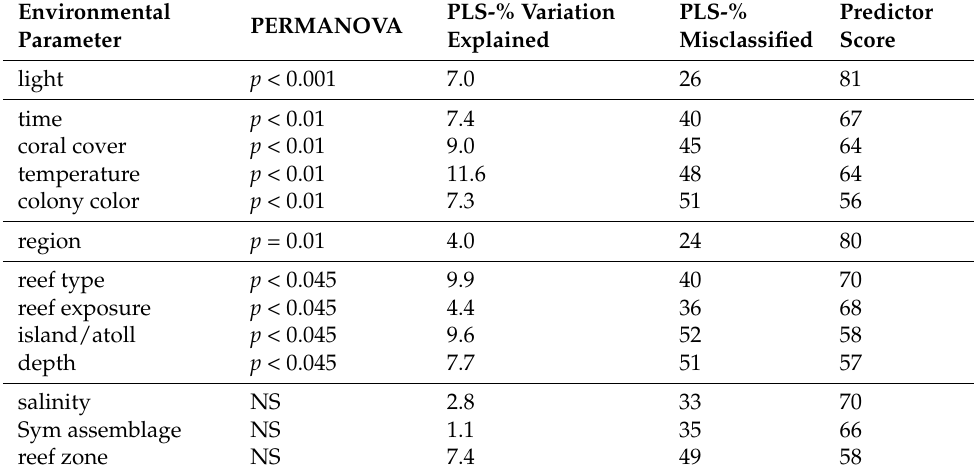
Table 2. Comparison of methods on the Pocillopora damicornis multivariate response (10 response variables). Permutational multivariate ANOVA (PERMANOVA; similarity (Euclidean distances) among standardized data) and partial least squares (PLS) were carried out with the exclusion of eight outliers and two samples collected in the late afternoon (n = 89). Environmental parameters with the same PERMANOVA p -values are ranked based on their “predictor score,” defined